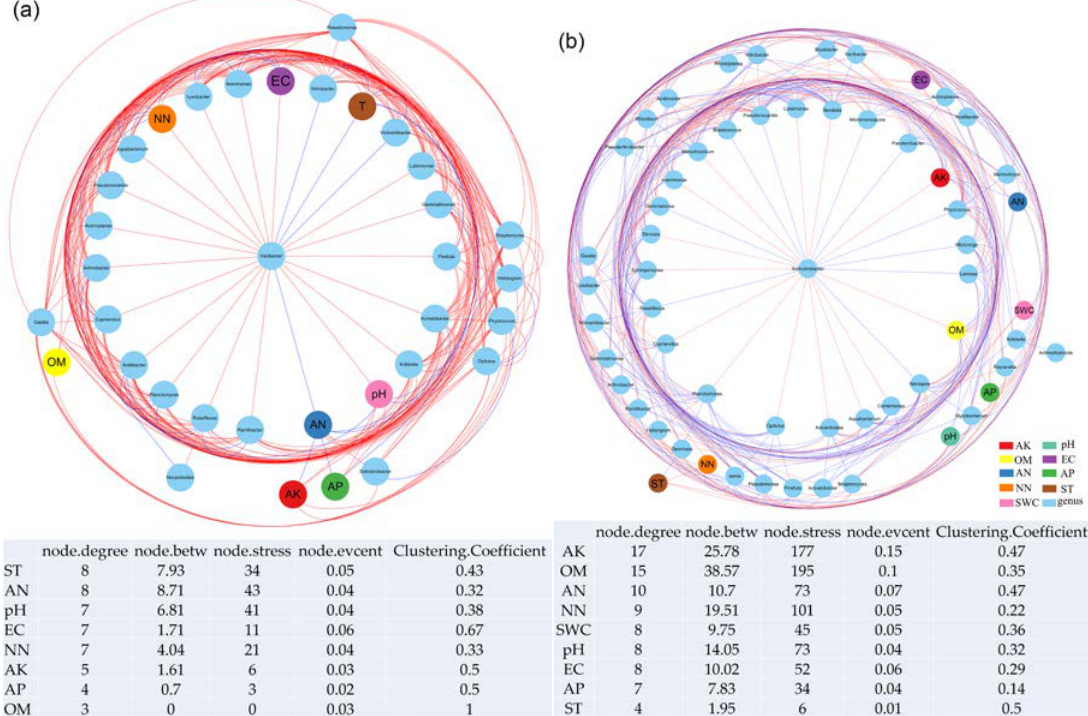
Figure 7. Radial layout plot between different genera and soil physicochemical properties in mining subsidence area ( a ) and vegetation rehabilitation area ( b ). node.degree: the topological property of a node in a network. node.betw: betweenness, the ratio of paths that pass through the node, which serves as a broker when it is high. node.stress: the number of geodesic paths that pass through one node. node.evcent: the degree of a central node that is connected to other central nodes. Clustering.Coefficient: hierarchical properties of networks, describing how well a node is connected with its neighbors. More detailed information can be found in Deng et al. [46].